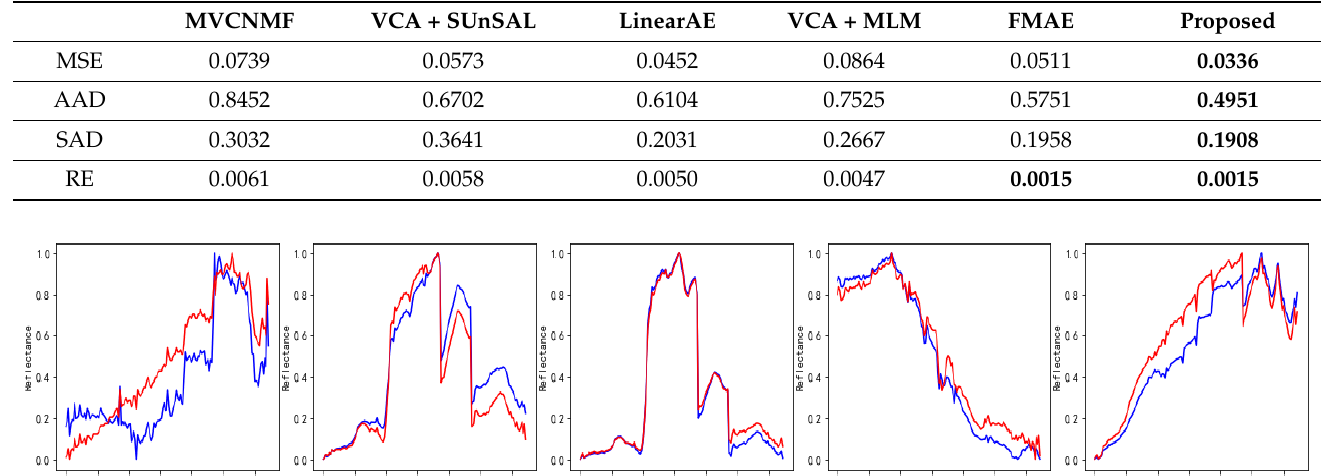
Table 5. Comparison of different methods on Urban. Best results are reported in bold.